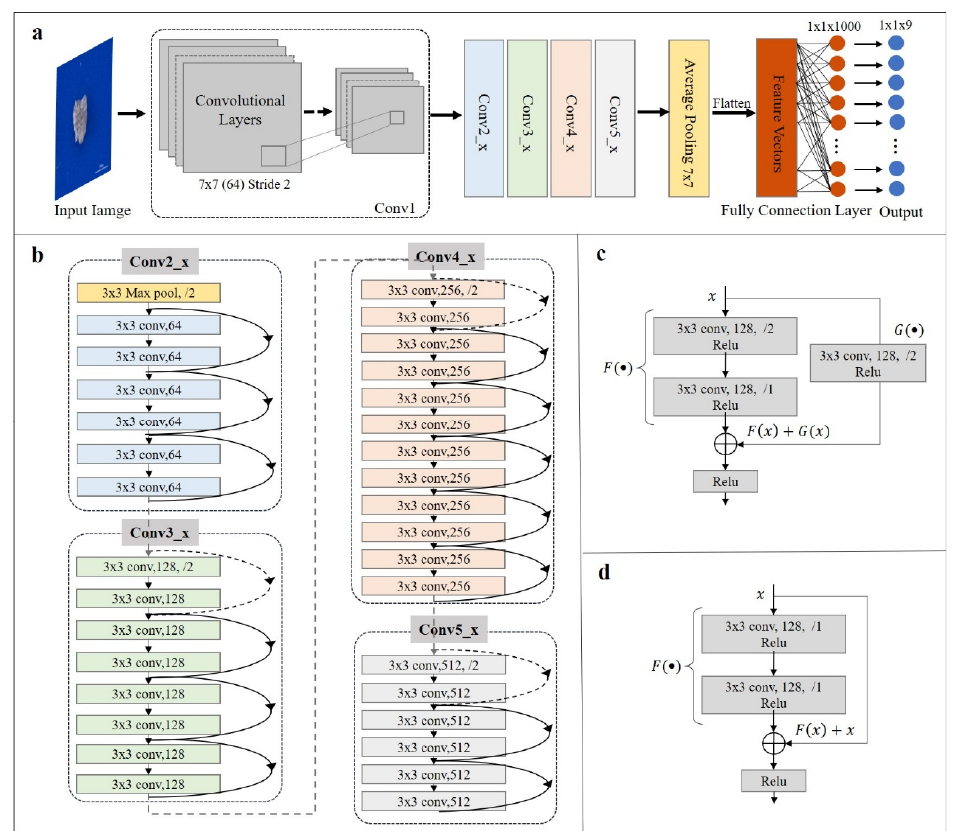
Figure 4. Schematic of ResNet-34. ( a ) The overall structure of ResNet-34. It consists of a convolutional unit (Conv1) and four residual blocks (Conv2_x, Conv3_x, Conv4_x and Conv5_x), which generate the final probability vectors and output the category labels by average pooling layer and fully connected layer; ( b ) Internal structure of the four residual blocks. Dashed and solid lines between layers represented two different short-circuit connection mechanisms of the residual units; ( c ) The short-circuit connection mechanism (taking Conv3_x block as an example) indicates that the number of input and output channels are different, corresponding with dashed lines in ( b ); ( d ) The short-circuit connection mechanism (taking Conv3_x block as an example) indicates that the number of input and output channels are the same, corresponding with solid lines in ( b ).